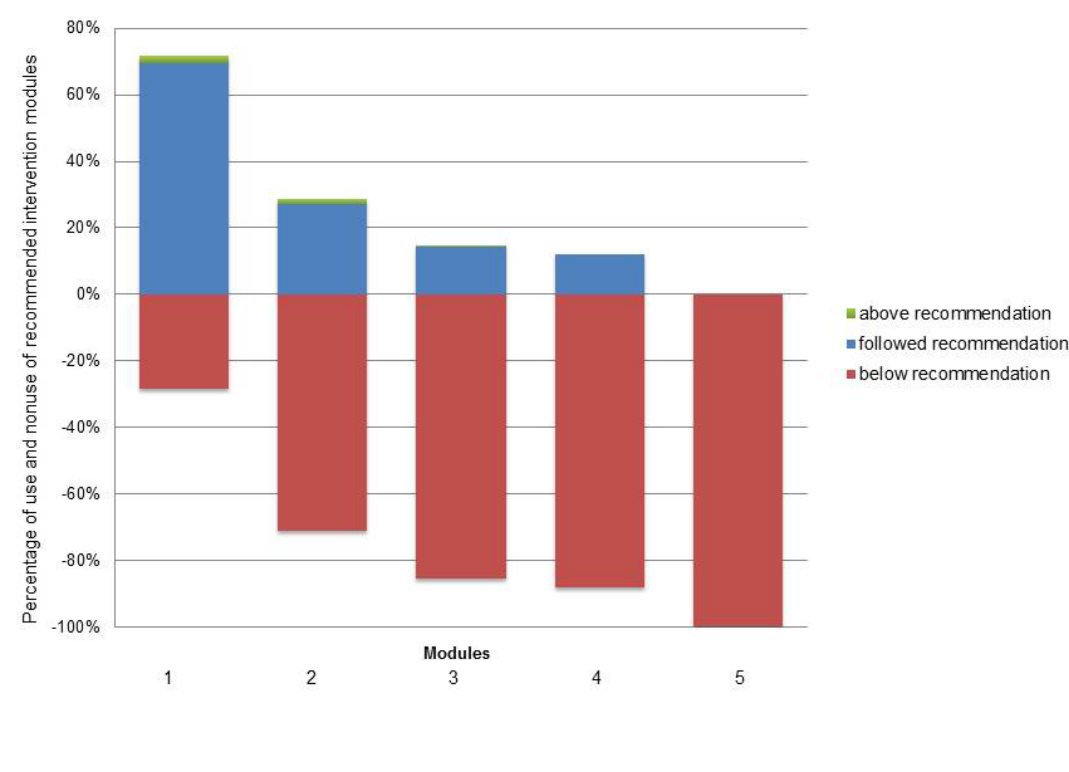
Figure 1. Percentage of participants who used the intervention in the recommended